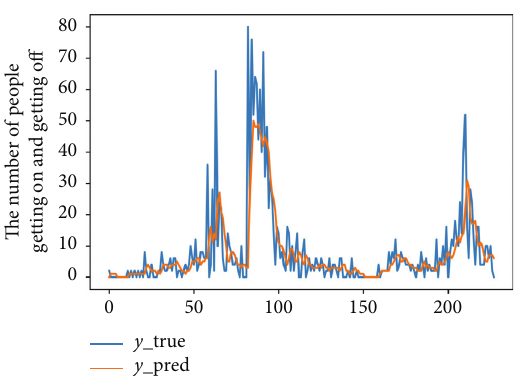
Figure 25: Regression integration prediction results when the time step is 6 h.